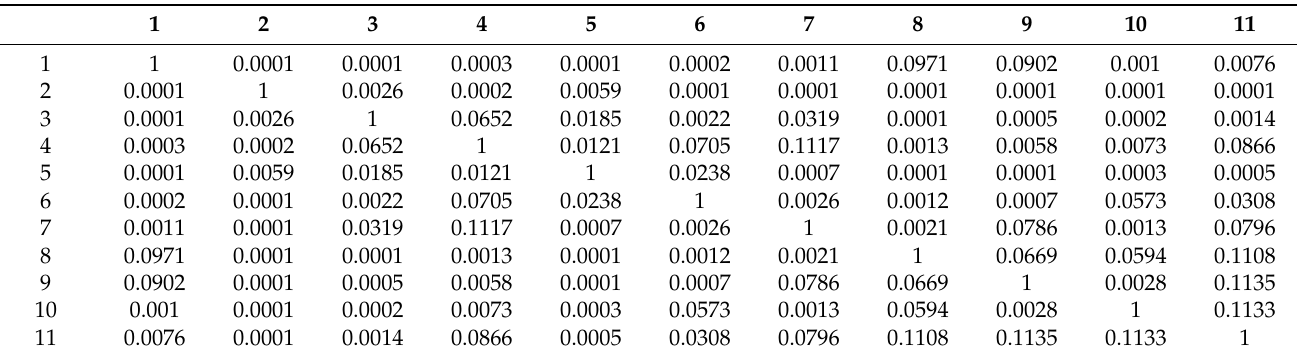
Table 1. Pairwise overlap matrix for the 11 categories for